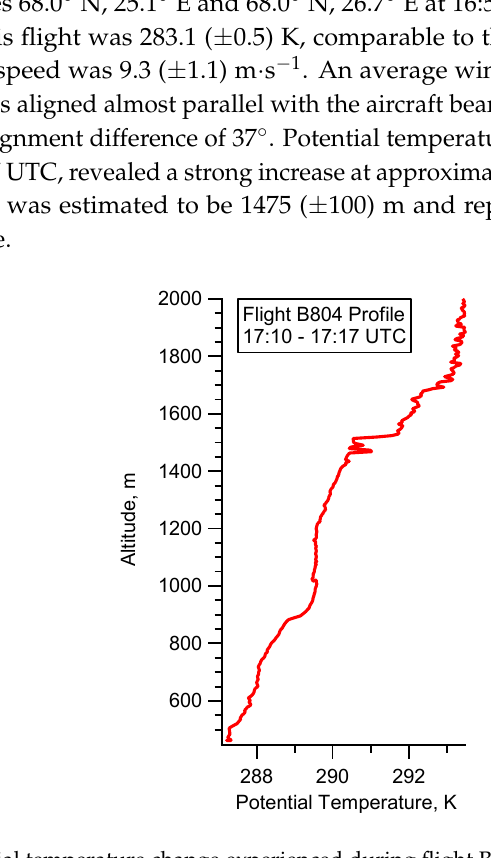
Figure 3. The potential temperature change experienced during flight B804’s ascent at time 17:10–17:17 UTC, where a large temperature increase is observed at 1475 m altitude.